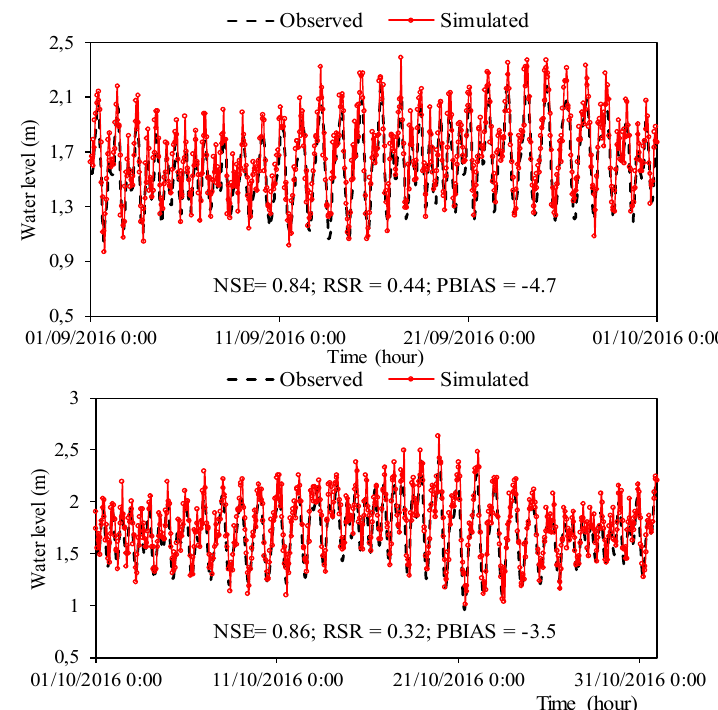
Figure 6. Calibration and validation of water level at Quy Nhon station.